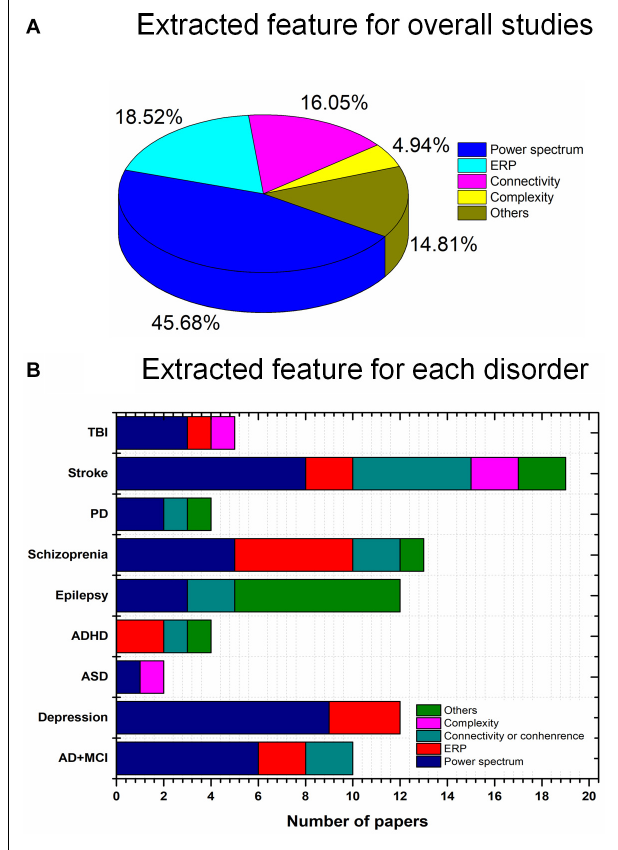
FIGURE 8 | Extracted features (total 67 studies): (A) overall and (B) individual disorders.